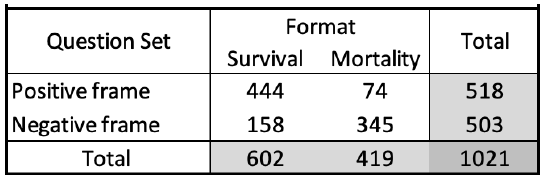
Figure 1. Collective sample results.